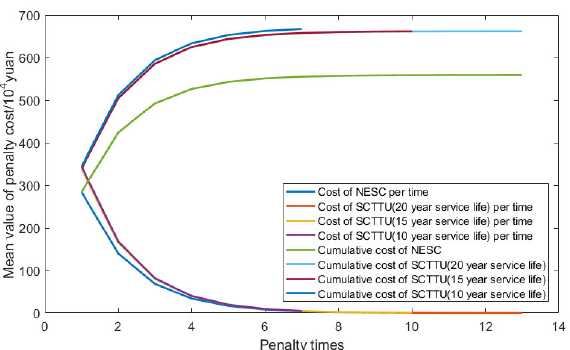
Figure 9. Comparison of penalty cost curve between NESC and SCTTU.